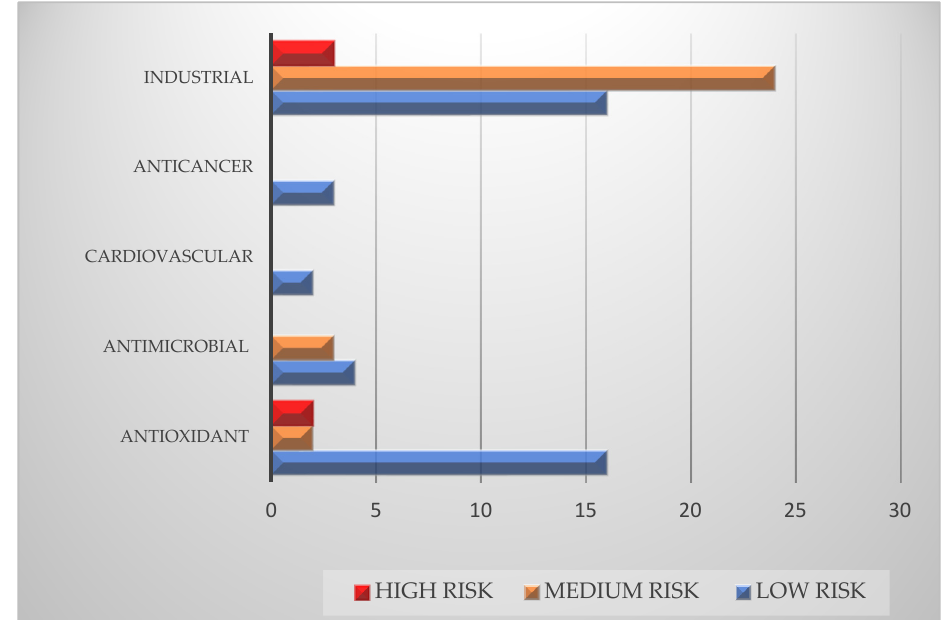
Figure 4. The assessment of bias risk is based on a checklist adapted from the Cochrane Handbook for Systematic Reviews of Interventions [17] and Collaboration for Environmental Evidence (CEE) Guidelines and Standards for Evidence Synthesis in Environmental Management, in conformance to ROSES reporting standards [18,19]. The studies regarding the different biological activities and the industrial uses have been classified into high (red), medium (orange), and low (blue) risks of bias.